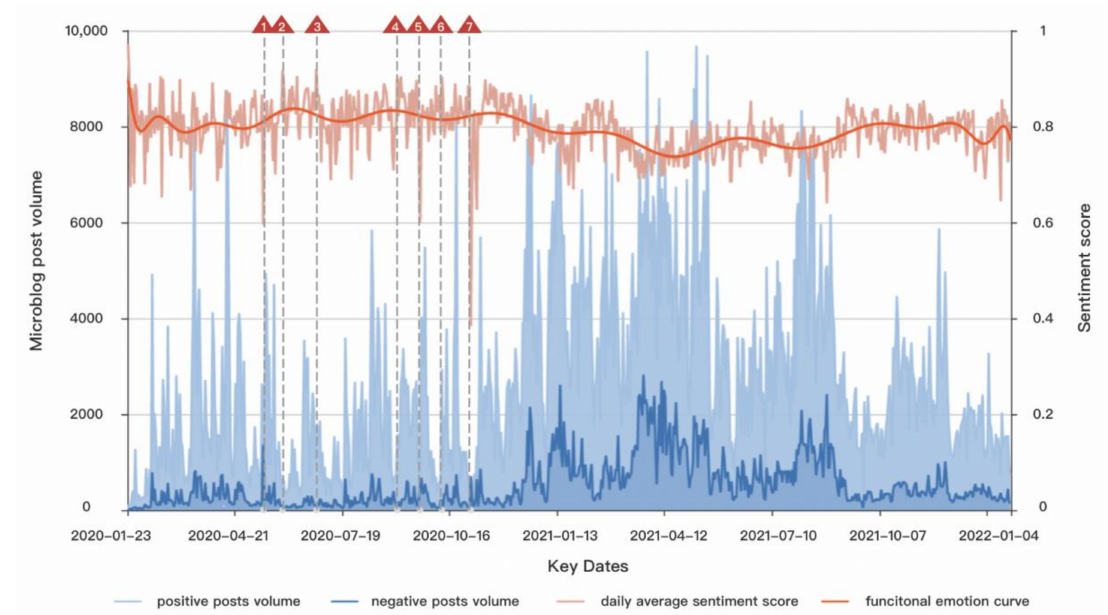
Figure 7. The smooth curve of average sentiment scores, and positive and negative microblog posts volume. (The red triangle represents the date with the largest fluctuation in the daily average sentiment